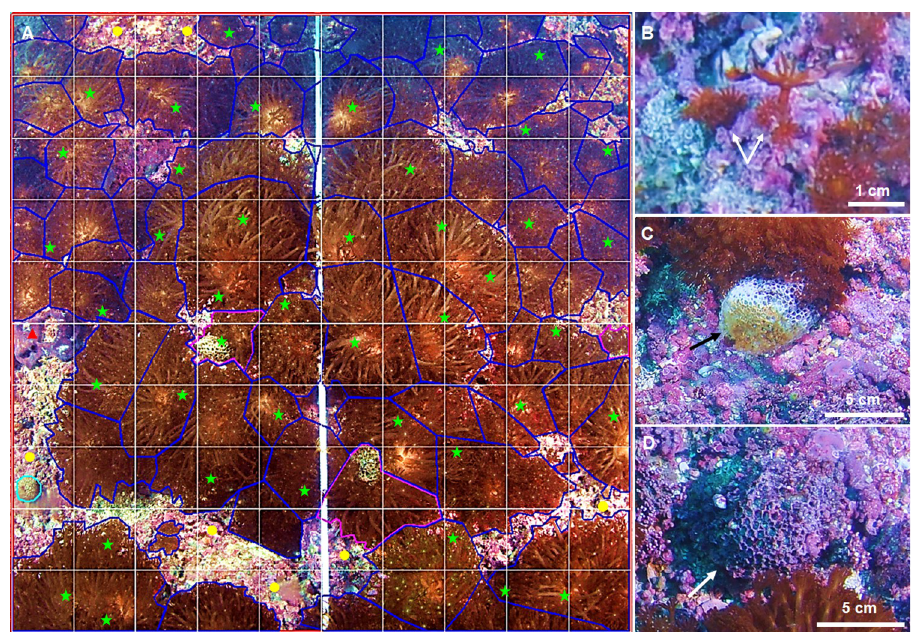
Fig 3. (A) 1m 2 photo quadrat taken from a depth of 15 m of BC using an underwater camera and image analysis methods of freehand regions and random point counts using photoQuad software. The freehand analysis involved the manual drawing of outline around A . japonica colonies. Blue lines indicate live colonies, pink lines indicate bleached colonies, and skylines indicate dead colonies. The random point counts were performed on 50 randomly allocated points to benthic organisms. Green points indicate A . japonica , yellow points indicate non-geniculate corallines, and redpoint indicate Lissoclinum sp. appeared on a 1m 2 photo quadrat. (B) a close-up picture of small colonies (arrow) of A . japonica identified from an underwater image. (C) Bleached colony (arrow) with coral tissue lost its color and whiting colonies. (D) the dead colony (arrow) with all coral tissue disappeared.